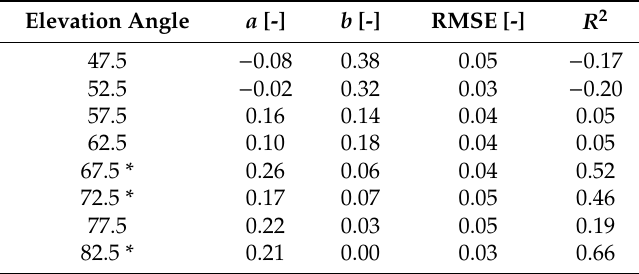
Table 3. ω vs. NDVI Fitting Parameters.